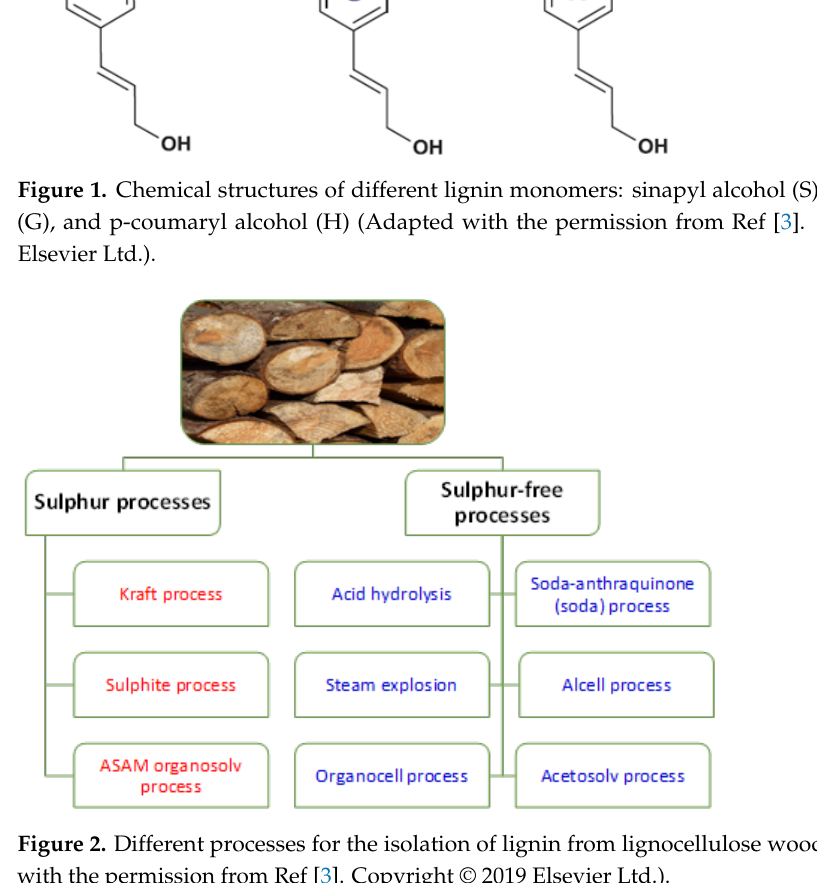
Figure 2. Different processes for the isolation of lignin from lignocellulose wood matrix (Adapted with the permission from Ref [3]. Copyright © 2019 Elsevier Ltd.).